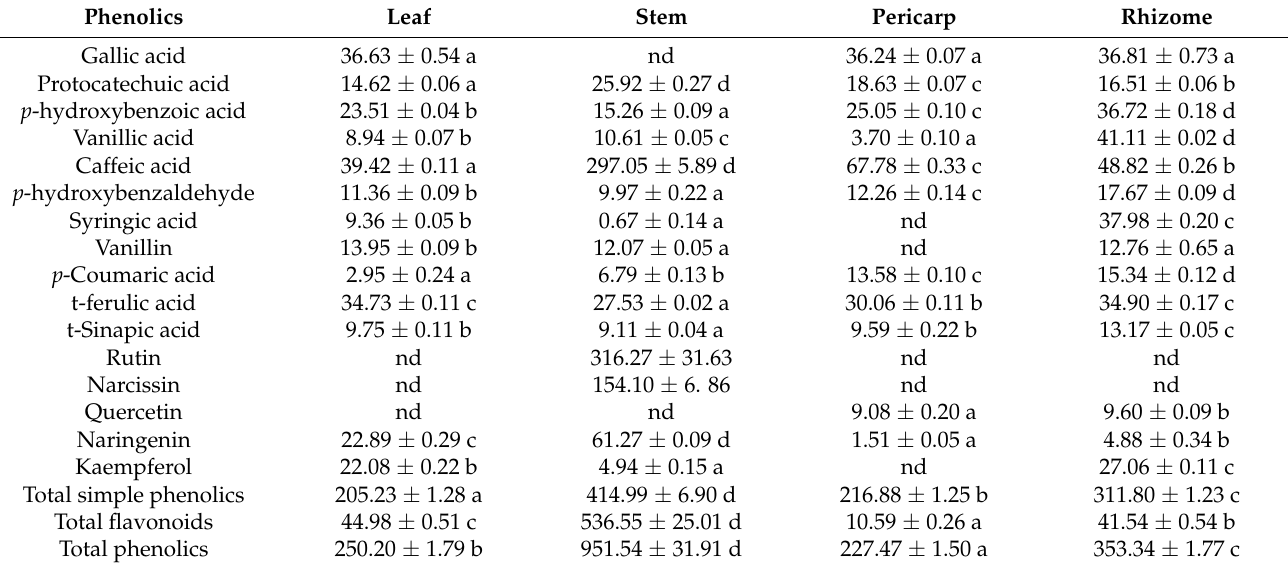
Table 1. Flavonoids and simple phenolic compositions of different plant part extracts from A. acutifolius.